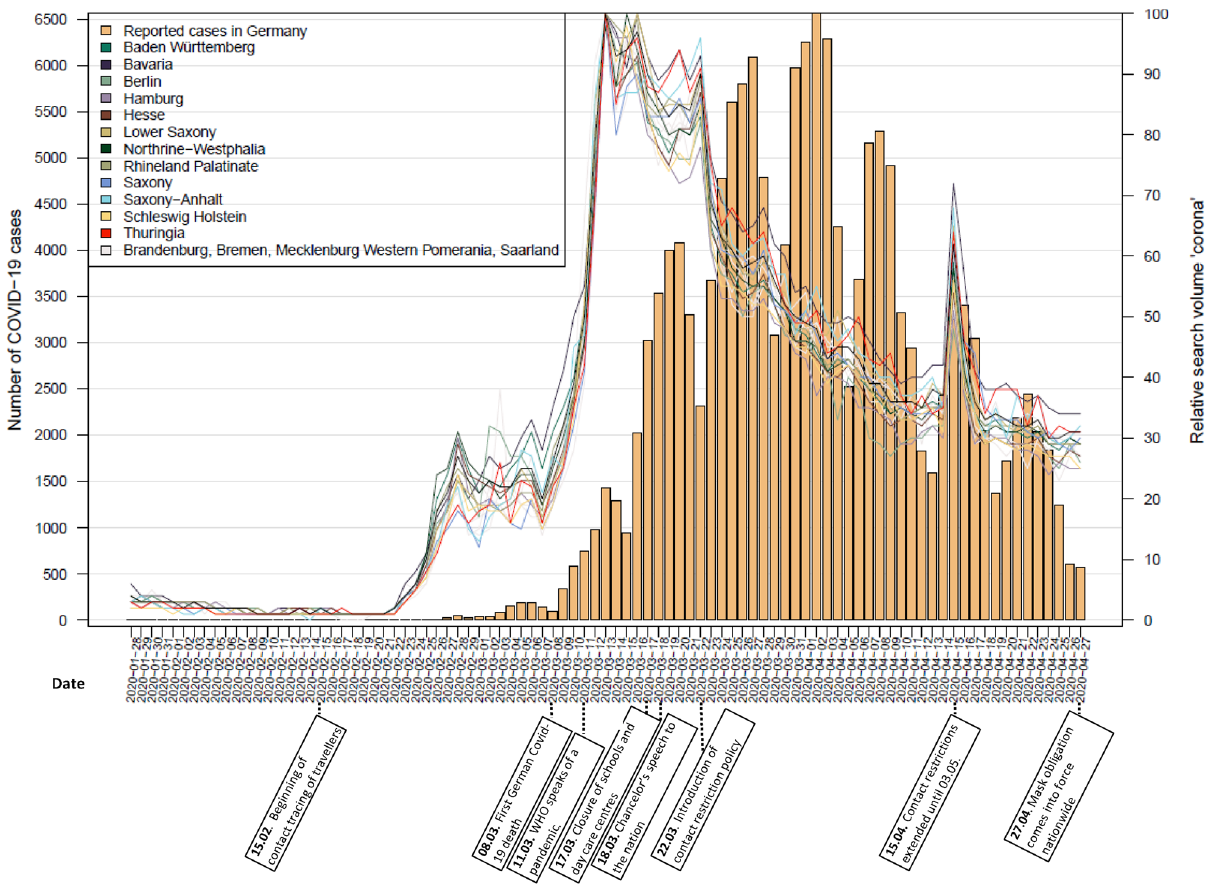
Figure 1. Nationally reported COVID-19 cases and RSV for the search term ‘corona’ at state